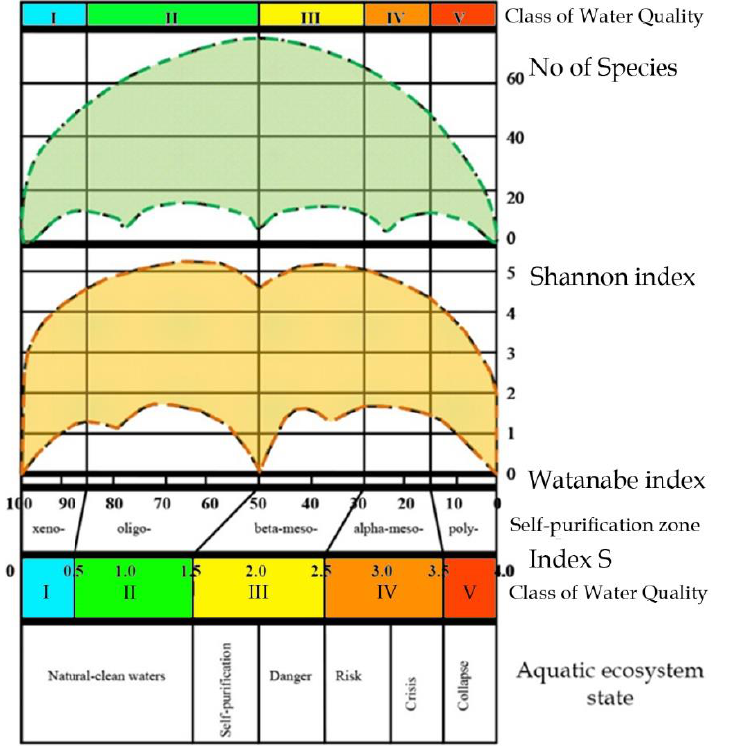
Figure 5. Empirical Ecosystem Model with the relationship between the saprobity indices of Sládeček and Watanabe with Water Quality Classes and the state of the aquatic ecosystem according to [18].